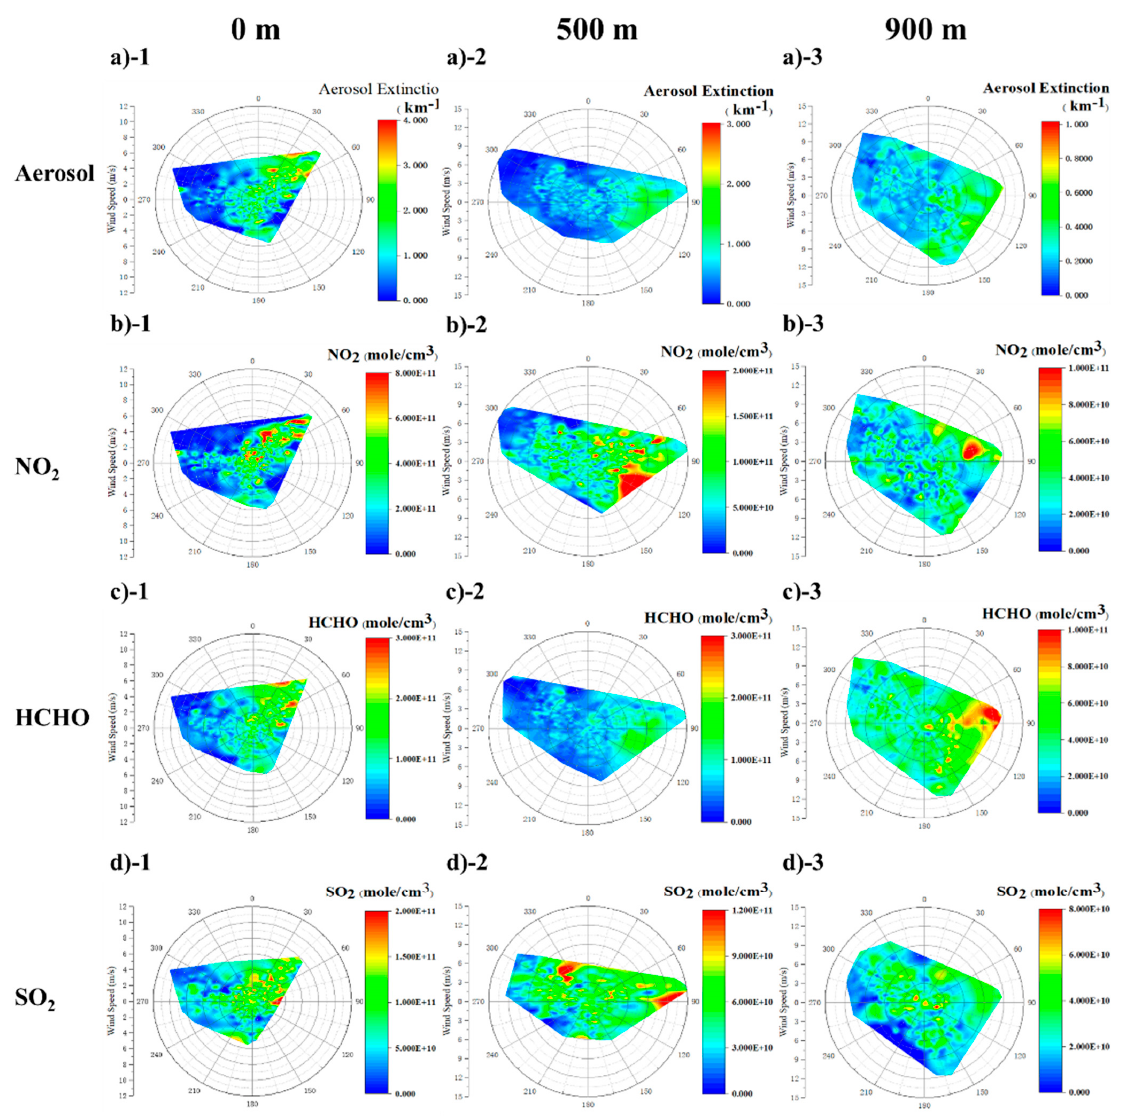
Figure 5. Polar plots of four kinds of pollutants during the observation period (subfigure ( a ) for aerosol, ( b ) for NO 2 , ( c ) for HCHO and ( d ) for SO 2 ).